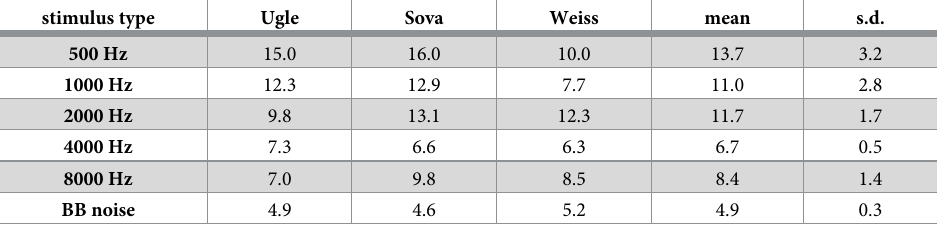
Table 1. MAA values in degree, mean values and s.d. of three barn owls (Ugle, Sova, and Weiss) as a function of stimulus type. Data were obtained in the single reference paradigm. stimulus type Ugle Sova